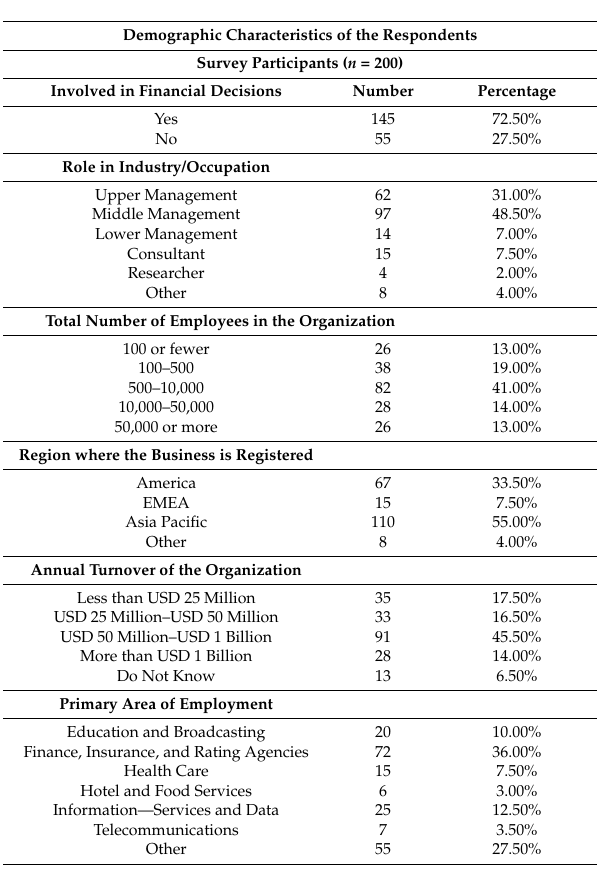
Table 2. Demographic Characteristics of the